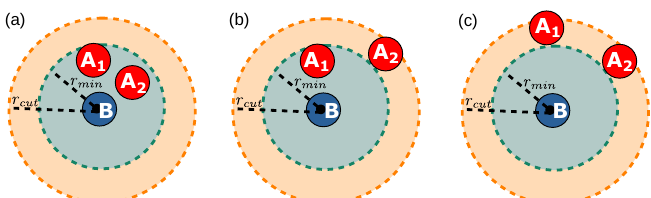
Figure 1: Depiction of three particles interacting that can form and swap A-B bonds. There are three different scenarios in which the three body potential is active. In (a) both A particles are within r body term is constant. In (b) only one particle is within r a repulsion from B due to eqn (4). In (c) both A feel a three-body